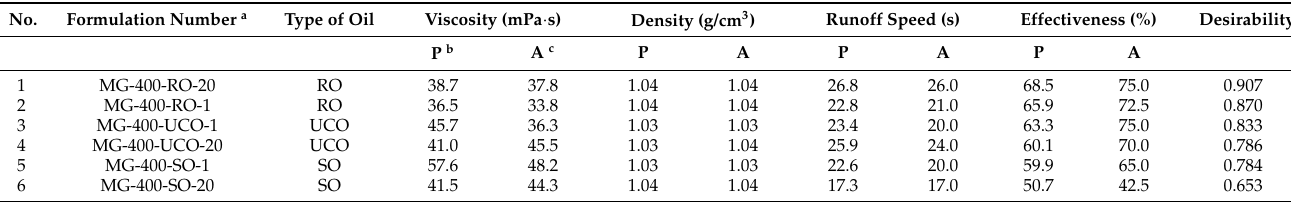
Table 4. Candidates for the optimal eco-friendly graffiti remover proposed by D -Optimal model optimization based on desirability function and comparison of predicted and actual values.